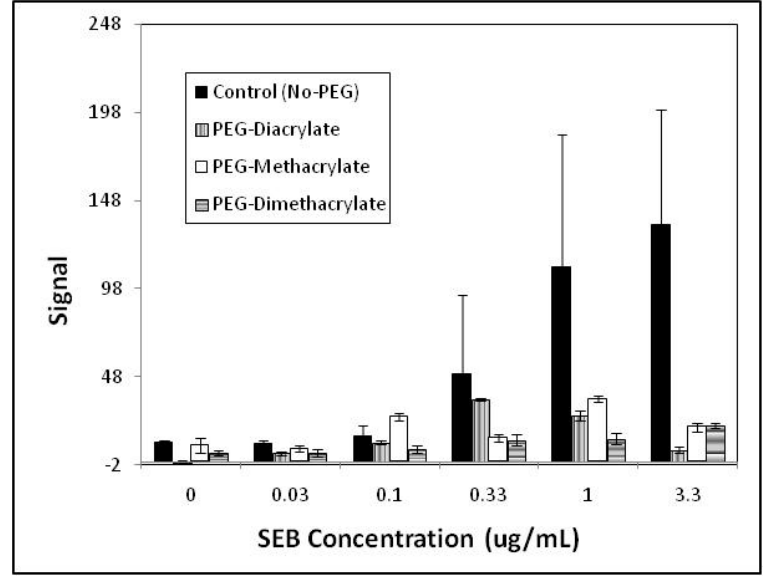
Figure 3. Fluorescence measured from non-specific binding in sandwich immunoassays for SEB. Unmodified hydrogels, PEG-diacrylate, PEG-methacrylate and PEG- dimethacrylate modified hydrogels were compared (i.e., areas highlighted in orange rectangle in Figures 2A and 2B). Images of the fluorescence arrays were analyzed using Adobe Photoshop CS3 Extended (from RGB color values). Values reported represent replicate of six (±